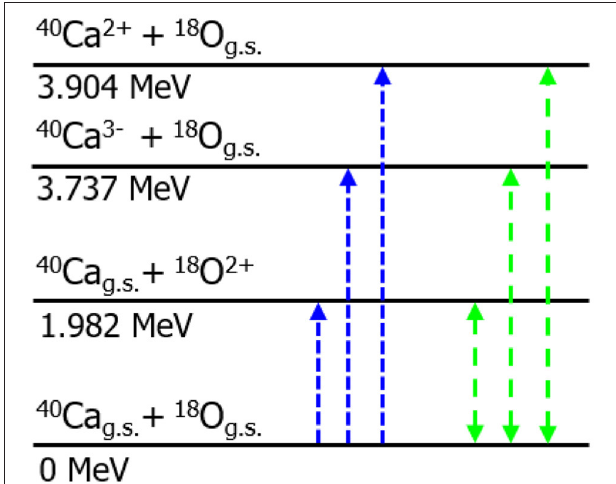
FIGURE 5 | Coupling scheme adopted in the DWBA (blue dotted single arrows) and CC (green dashed double arrows) calculations in the present work. In DWBA, the single arrows sketch that back coupling effects are not